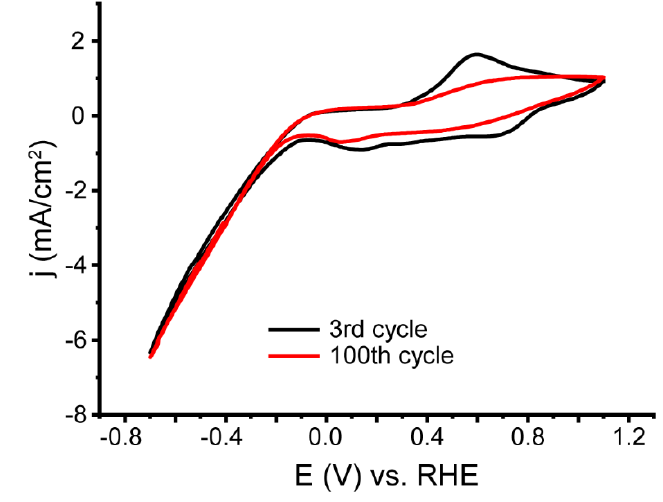
Figure 7. CV of the PANI/AgPt composite, 3rd and 100th cycles.